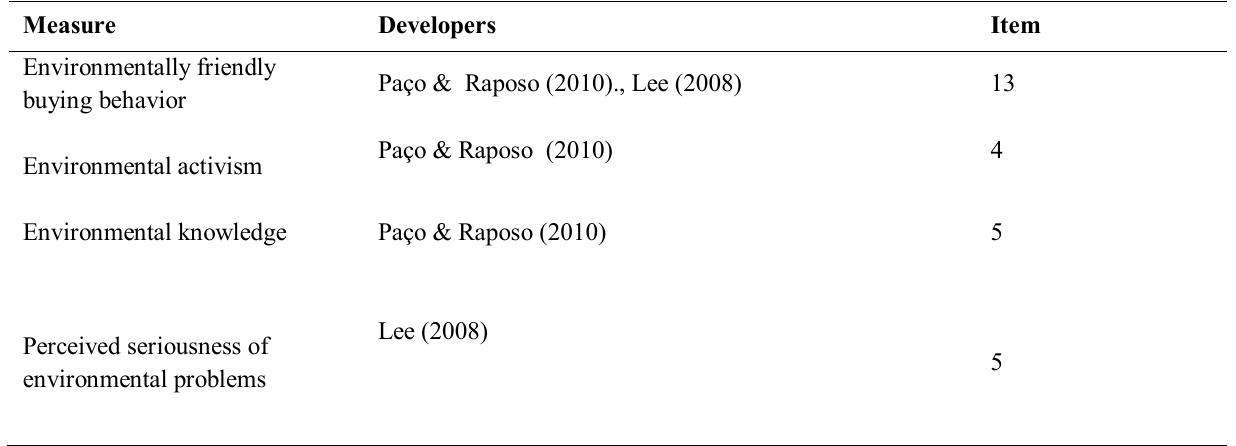
Table 1 . Measures Used in